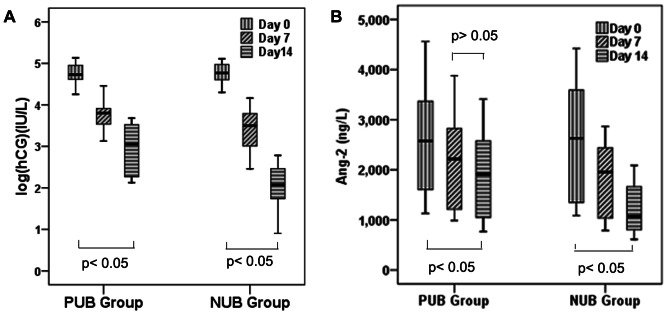
Quantitative Values of Serum β-hCG and Ang-2 After Medical Abortion.The box indicates the lower and upper quartiles and the central line marks the median. The points at the end of the whiskers represent the range of the values.